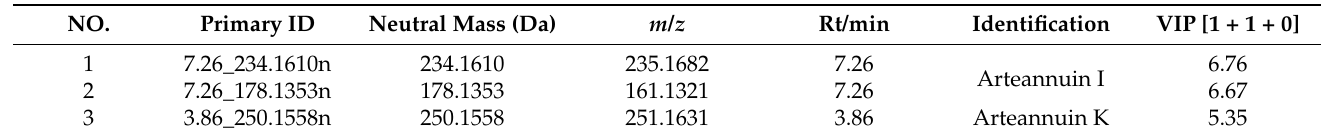
Figure 4. OPLS-DA of ArtH-Et 2 O and 2% ArtH-Et 2 O. ( A ) Score plot in positive-ion mode. ( B ) S-plot in positive-ion mode. ( C ) Score plot in negative-ion mode. ( D ) S-plot in negative-ion mode. Red dots represent VIP > 5 data. ( n = 3). Table 5. The differential chemical compositions positively correlated with antimalarial activity between ArtH-Et 2 O and 2% ArtH-Et 2